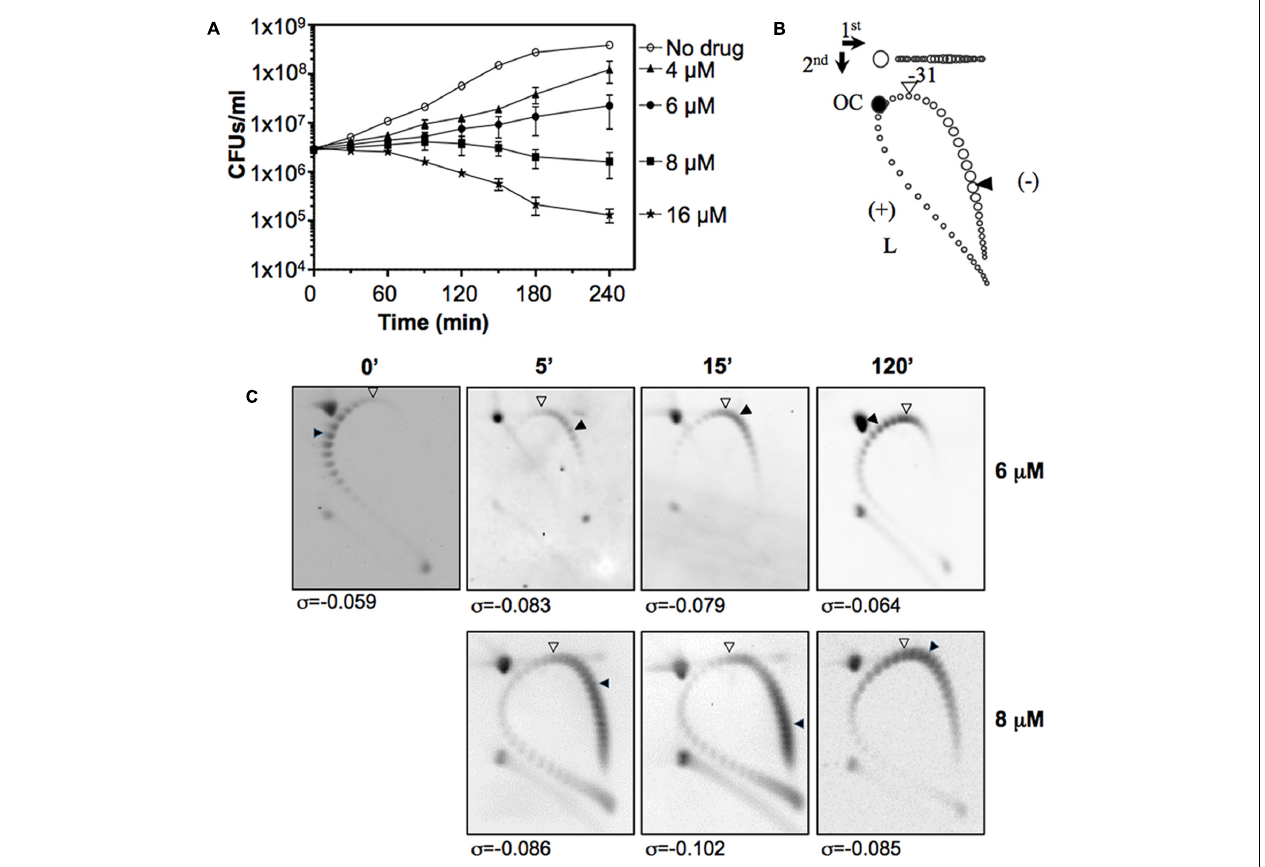
FIGURE 7 | Seconeolitsine affects cell viability and induces hypersupercoiling. (A) Viability of R6 (pLS1) in a medium containing different SCN concentrations. Samples were taken before the addition of the drug (zero time), and at the indicated times were plated on drug-free agar medium. (B) Diagram showing topoisomer distribution in plasmid pLS1 subjected to 2D-agarose gel electrophoresis run in the presence of 5 and 15 µ g/ ml chloroquine in the first and second dimensions, respectively. OC, open circle; L, linear form. A white arrowhead points to the topoisomer migrating with a (cid:49) Lk of 0 in the second dimension; it had a (cid:49) Wr of –31 in the first dimension. A black arrowhead points to the more abundant topoisomer. (C) Distribution of pLS1 topoisomers in 2D-gels after treatment with the indicated SCN concentrations. The supercoiling density ( σ ) values are indicated. Taken from Ferrándiz et al. (2016a), with